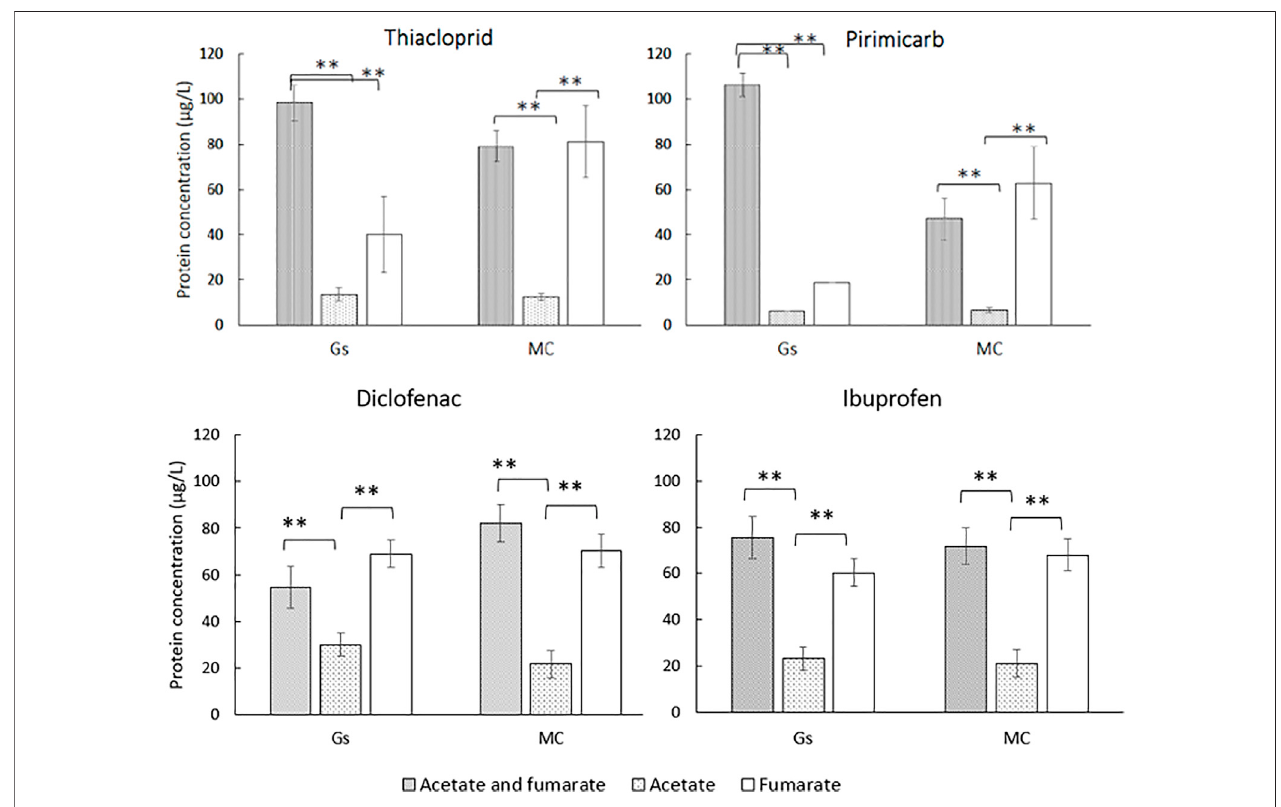
FIGURE 6 | Bacterial growth measured after a 2-week incubation period. **indicates statistical difference ( p ≤ 0.01, n = 3, one-way ANOVA, factor medium). Gs = G. sulfurreducens ; MC = Mixed culture.